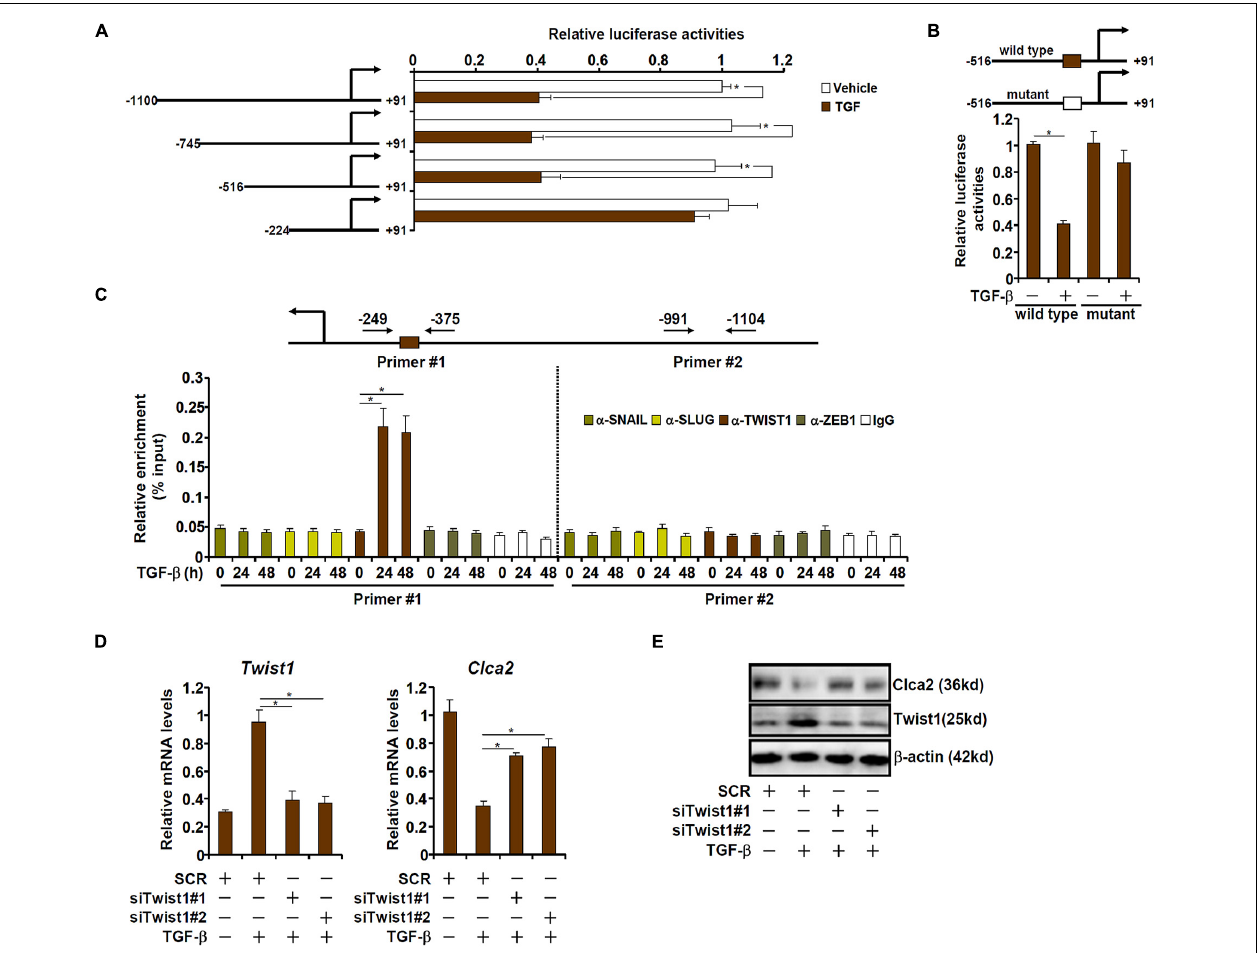
FIGURE 2 | TWIST1 mediates Clca2 trans- repression in cardiac fibroblasts. (A) Different Clca2 promoter-luciferase constructs were transfected into mouse embryonic fibroblasts (MEFs) followed by treatment with TGF- β . Luciferase activities were normalized by protein concentration and GFP fluorescence. (B) Wild type and mutant Clca2 promoter-luciferase constructs were transfected into MEFs followed by treatment with TGF- β . Luciferase activities were normalized by protein concentration and GFP fluorescence. (C) Primary cardiac fibroblasts were treated with TGF- β (2 ng/ml) and were harvested at indicated time points. ChIP assays were performed with indicated antibodies. (D,E) Primary cardiac fibroblasts were transfected with indicated siRNAs followed by treatment with TGF- β (2 ng/ml). Gene expression was examined by qPCR and Western. Error bars represent SD (* p < 0.05, two-way Student’s t -test). All experiments were repeated three times and one representative experiment is